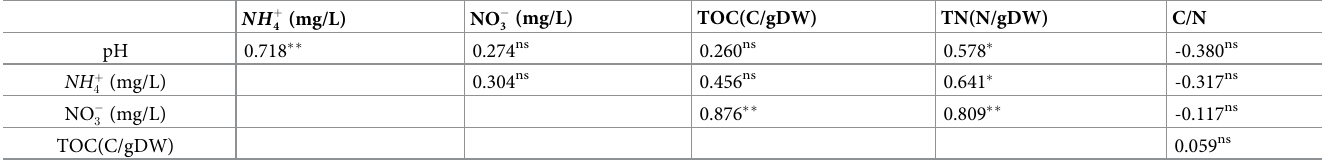
concentration and NH þ 4 3